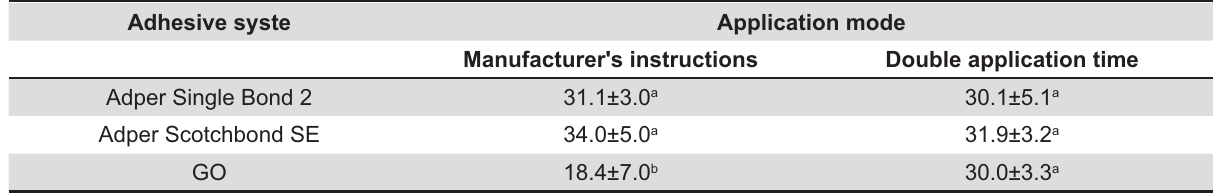
(cid:25)(cid:19)(cid:4)(cid:26)(cid:2)(cid:5)(cid:10)(cid:24)(cid:18)(cid:7)(cid:3)(cid:10)(cid:16)(cid:18)(cid:27)(cid:27)(cid:8)(cid:19)(cid:8)(cid:15)(cid:7)(cid:10)(cid:22)(cid:8)(cid:7)(cid:7)(cid:8)(cid:19)(cid:5)(cid:10)(cid:6)(cid:19)(cid:8)(cid:10)(cid:5)(cid:18)(cid:28)(cid:15)(cid:18)(cid:21)(cid:20)(cid:6)(cid:15)(cid:7)(cid:22)(cid:29)(cid:10)(cid:16)(cid:18)(cid:27)(cid:27)(cid:8)(cid:19)(cid:8)(cid:15)(cid:7)(cid:10)(cid:30)(cid:2)(cid:31)!"!#$"(cid:10)&(cid:10)(cid:7)(cid:4)(cid:7)(cid:6)(cid:22)(cid:10)(cid:4)(cid:27)(cid:10)#(cid:10)(cid:7)(cid:8)(cid:8)(cid:7)(cid:3)(cid:10)(cid:24)(cid:8)(cid:19)(cid:8)(cid:10)(cid:26)(cid:5)(cid:8)(cid:16)(cid:10)(cid:2)(cid:8)(cid:19)(cid:10)(cid:28)(cid:19)(cid:4)(cid:26)(cid:2) Table 2- Number and percentage of specimens (%) according to fracture pattern mode and the premature de-bonded specimens from each experimental condition (*)